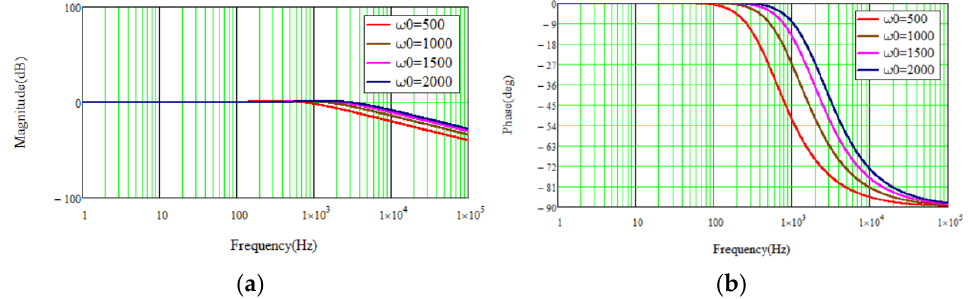
 − . ( a ) Magnitude. ( b ) Phase. Figure 6. The magnitude and phase frequency curves of φ z 1 − δ n . ( a ) Magnitude. ( b ) Phase. 1 n z 